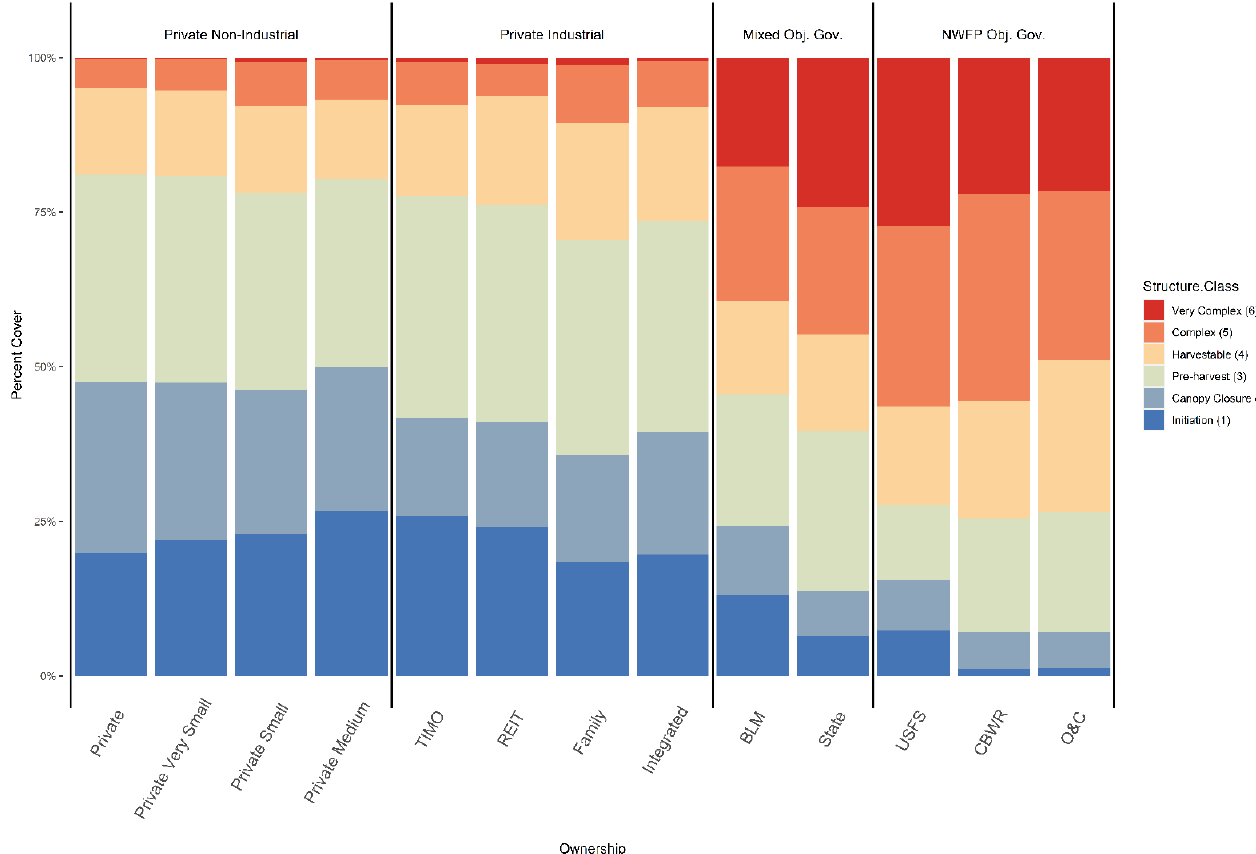
Figure 4. The percentage of area in each structure class per ownership. The thirteen ownership types are grouped according to the results of the hierarchical clustering of ownership types by percentage of area in each structure class.